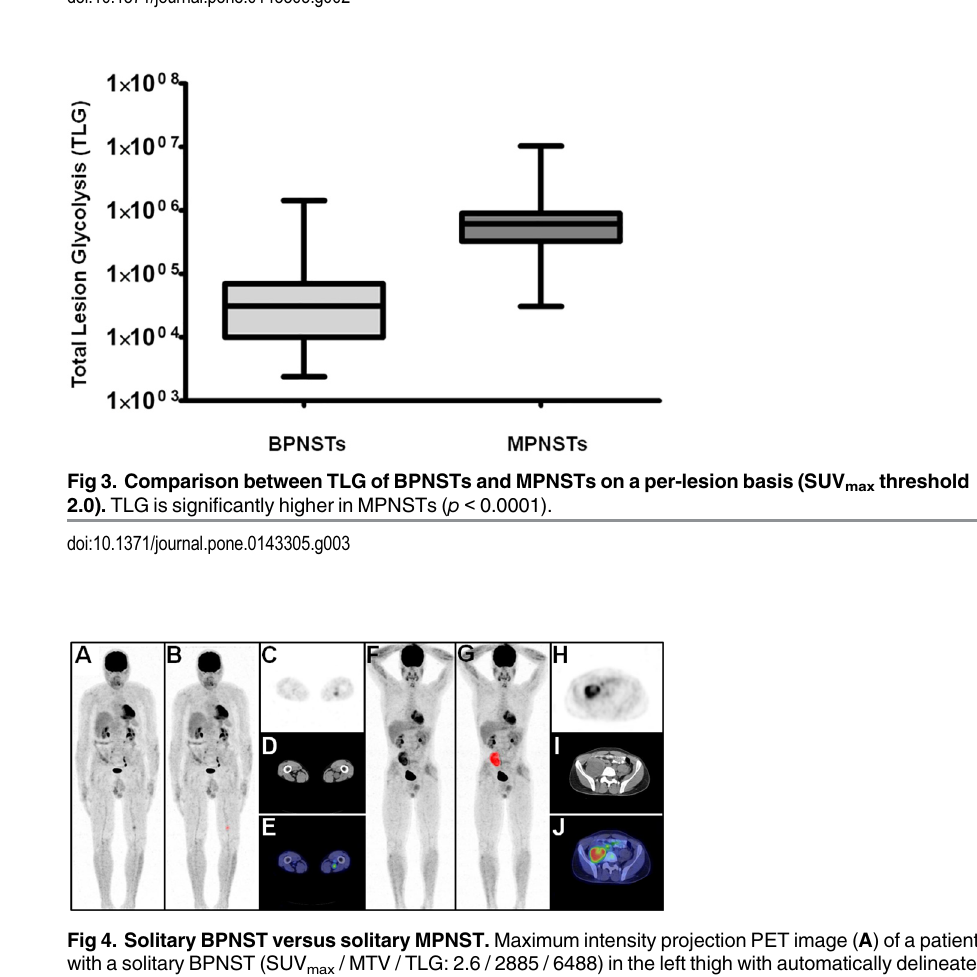
Fig 2. Comparison between MTV of BPNSTs versus MPNSTs on a per-lesion basis (SUV max threshold 2.0). MTV is significantly higher in MPNSTs ( p < 0.0001).